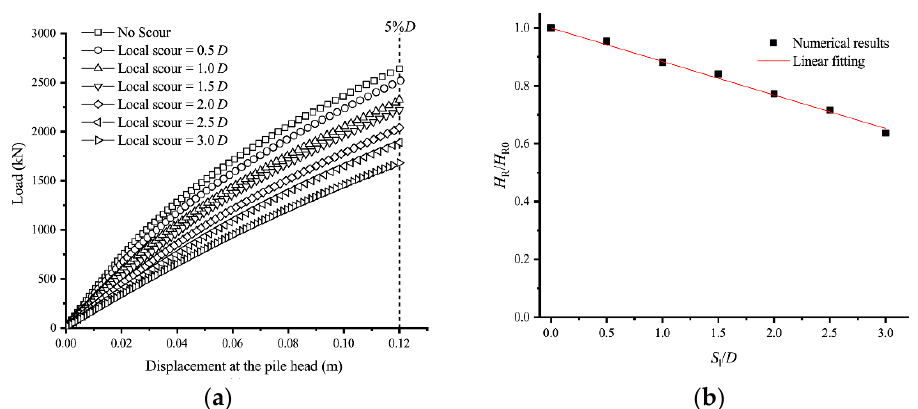
Figure 8. Local scour effects on ( a ) load-displacement curves and ( b ) pile capacities.